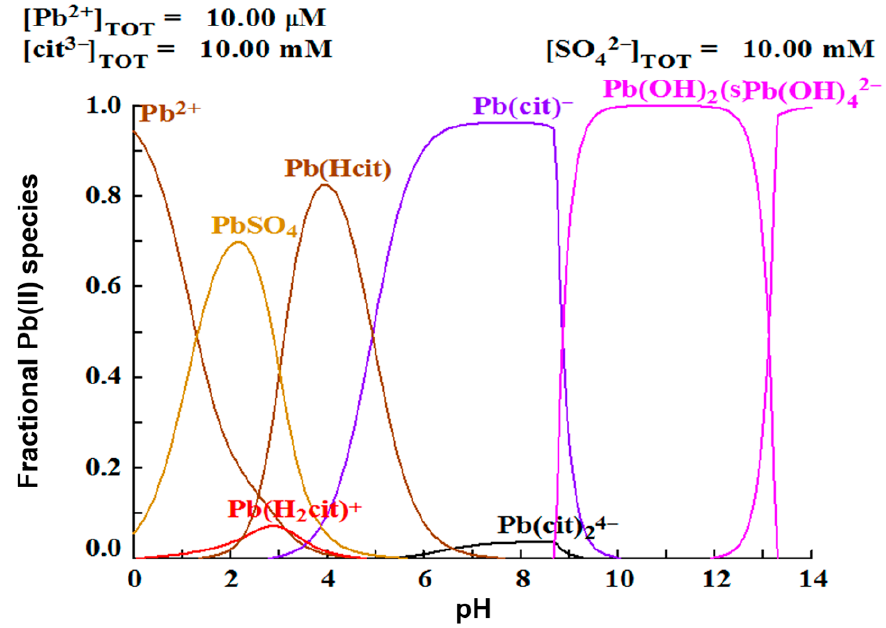
Figure 4. Species distribution diagram of lead in presence of citrate and sulfate ions.